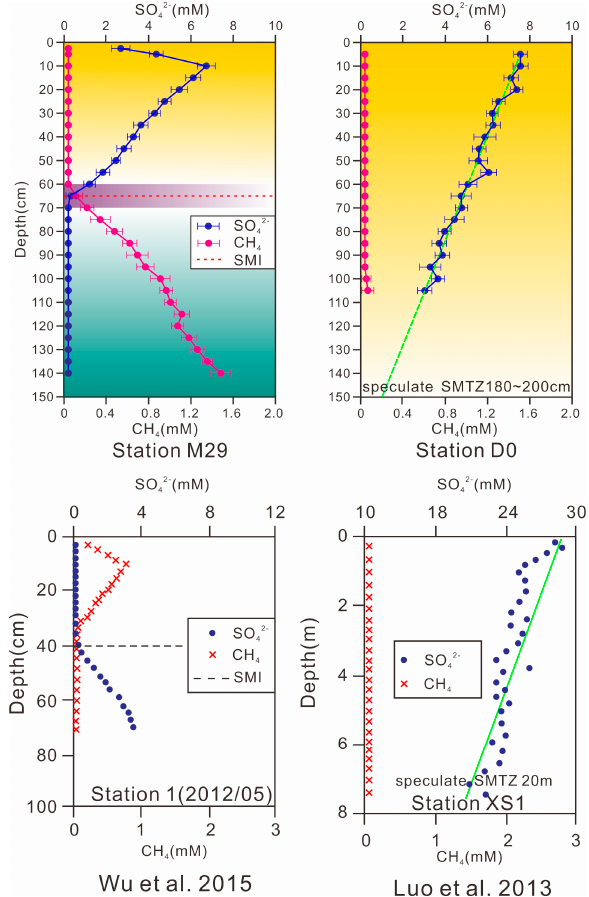
Figure 6. Depth comparison diagram of sulfate and methane transitional zone. The results of physicochemical property and isotopic composition analyses of the shallow surface sediments associated with typical pockmark morphologies showed that (1) along the northern coast of Fujian, there is almost no input of terrestrially sourced materials from large rivers, the C/N ratio is indicative of a marine facies, and marine biogas is the main component based on the carbon isotopic composition. In the argillaceous zone, active materials are less abundant, and the sulfate content has a tendency to decrease, but this trend is not obvious. (2) Outside the mouth of the Minjiang River, in the underwater delta of the estuary, the substrate consists of sand and mud, the C/N ratio indicates the input of terrestrially sourced substances, active substances are relatively abundant, the reduction of sulfate is strong, the SMTZ is relatively shallow, and the carbon isotopic composition suggests that biogenic gas is common. (3) In the submarine depression offshore of southern Fujian Province (off Dongshan Peninsula), the carbon isotopic composition of the sandy bottom material shows that the organic matter is of mixed origin, originating from both the sea and land; the biogenic gas of mixed pyrolysis is derived from less active material (indicating that the underlying formation contains oil, gas, and methane); the sulfate reduction is strong; and the SMTZ is